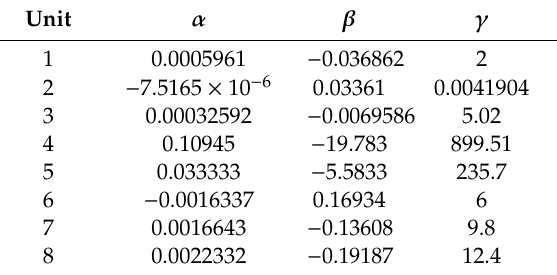
Table A3. CO X emission coe ffi